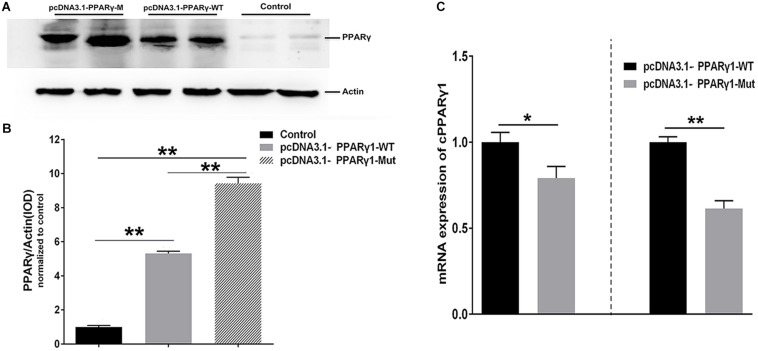
PPARγ1 translation is inhibited by its 5′ UTR uORF. (A) Detection of PPARγ1 protein levels. Equal amounts of the total cell lysates from the ICP1 cells transfected with either pcDNA3.1-PPARγ-WT or pcDNA3.1-PPARγ-Mut were separated and immunoblotted with an anti-PPARγ antibody. Actin was used as a loading control. (B) Quantification of PPARγ1 protein expression. Band intensities were measured by ImageJ software normalized to actin loading control. Data represent mean ± SEM. PPARγ1 protein expression was higher in the cells transfected with pcDNA3.1-PPARγ-Mut than in the cells transfected with the pcDNA3.1-PPARγ-WT (**P < 0.01, Student’s t-test). (C) Quantification of PPARγ1 mRNA by real-time RT-PCR in the ICP1 and DF1 cells transfected with the indicated constructs. PPARγ1 mRNA levels were normalized to the expression of the cells transfected with pcDNA3.1-PPARγ-WT. Data were expressed as the mean ± SEM, NONO was used as the internal mRNA control. n ≥ 3, *P < 0.05; **P < 0.01, Student’s t-test.